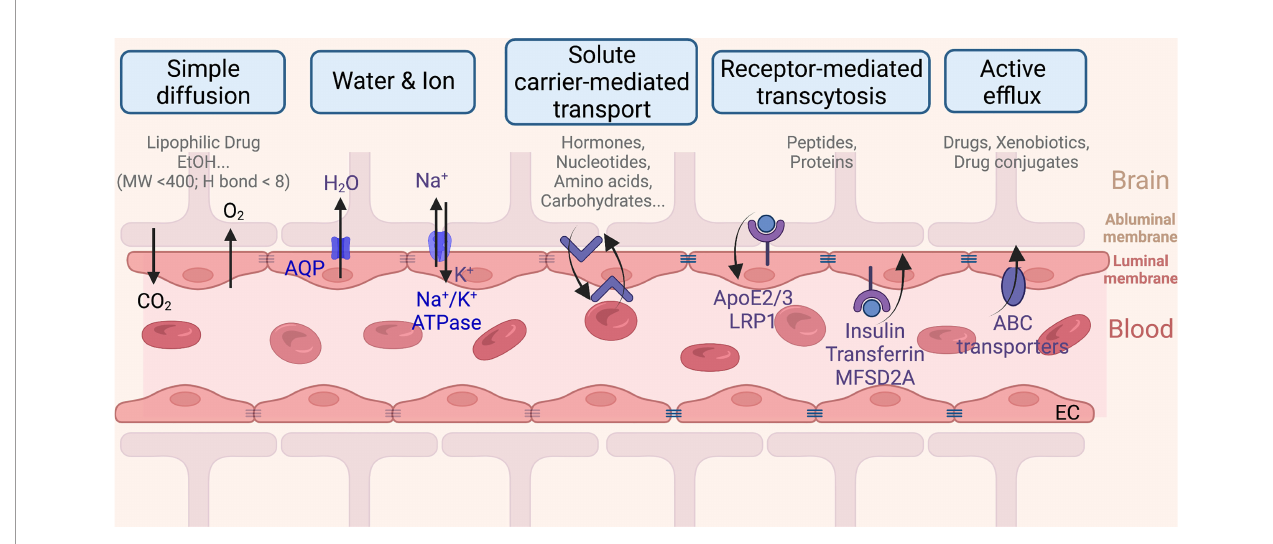
FIGURE 2 | The blood – brain barrier monitored transportation from the capillary endothelium to the